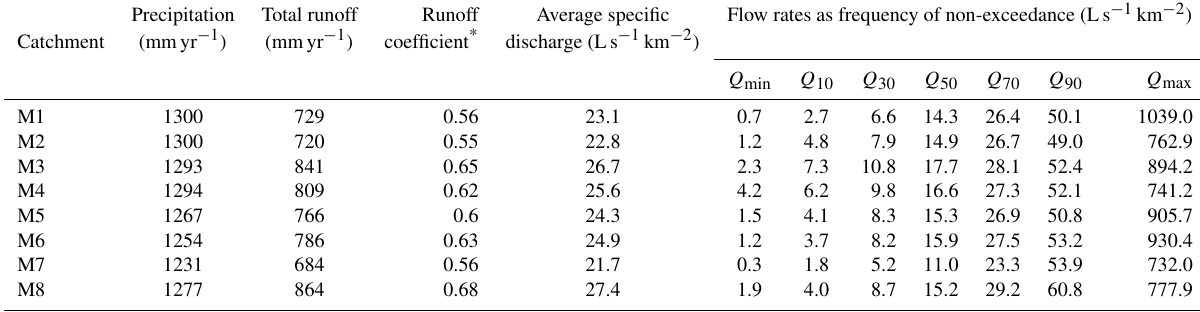
Table 3. Main hydrometric variables of the catchments. Precipitation Total runoff Runoff Average specific Flow rates as frequency of non-exceedance (Ls − 1 km − 2 )